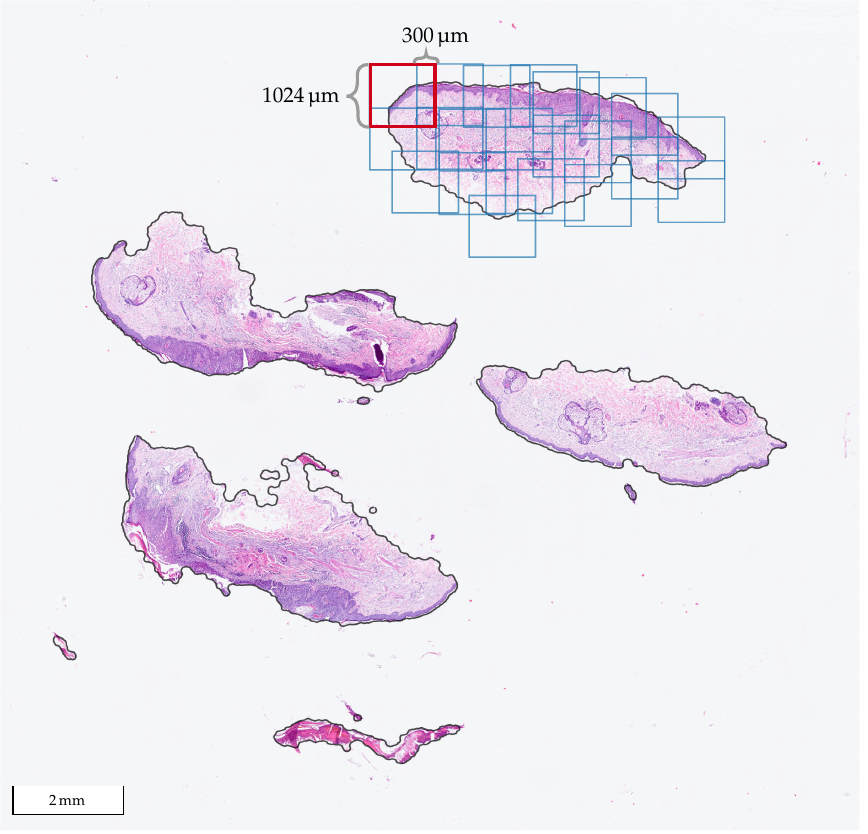
Figure 1. WSI from Center 0 with tissue cuts/sections that contain BD. Prior to the tile extraction, the tissue areas (solid black contour) are detected. The tiles are 1024µm × 1024µm at a 10 × level of magnification and are extracted with at least 300µm overlap in each direction, as shown in one of the cuts.